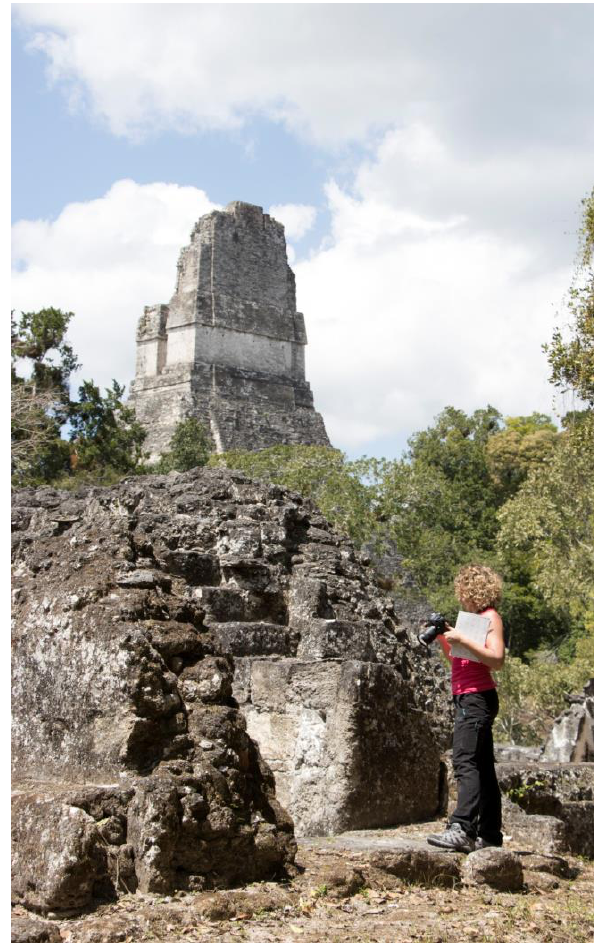
Figure 5. Photogrammetric survey at Tikal, Guatemala. (Photo C. Vidal 2017).